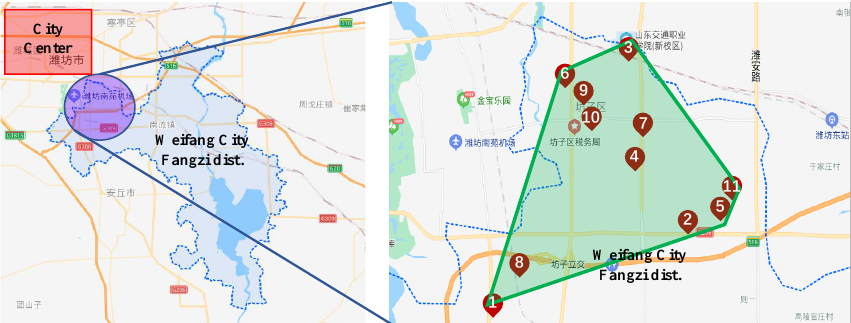
Figure 7. The geographical locations of the 11 buildings.